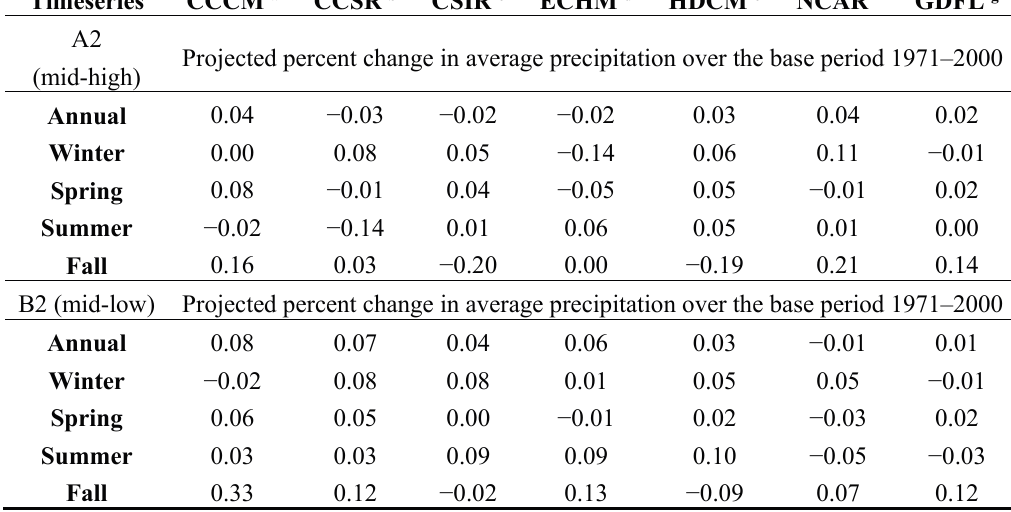
Table 2. Projected percent change in average annual and seasonal precipitation at HCN# 333758 (Hillsboro, OH) based on the outputs of seven GCMs for the period 2010–2039 (baseline 1971–2000). Deltas from General Circulation Models Output for